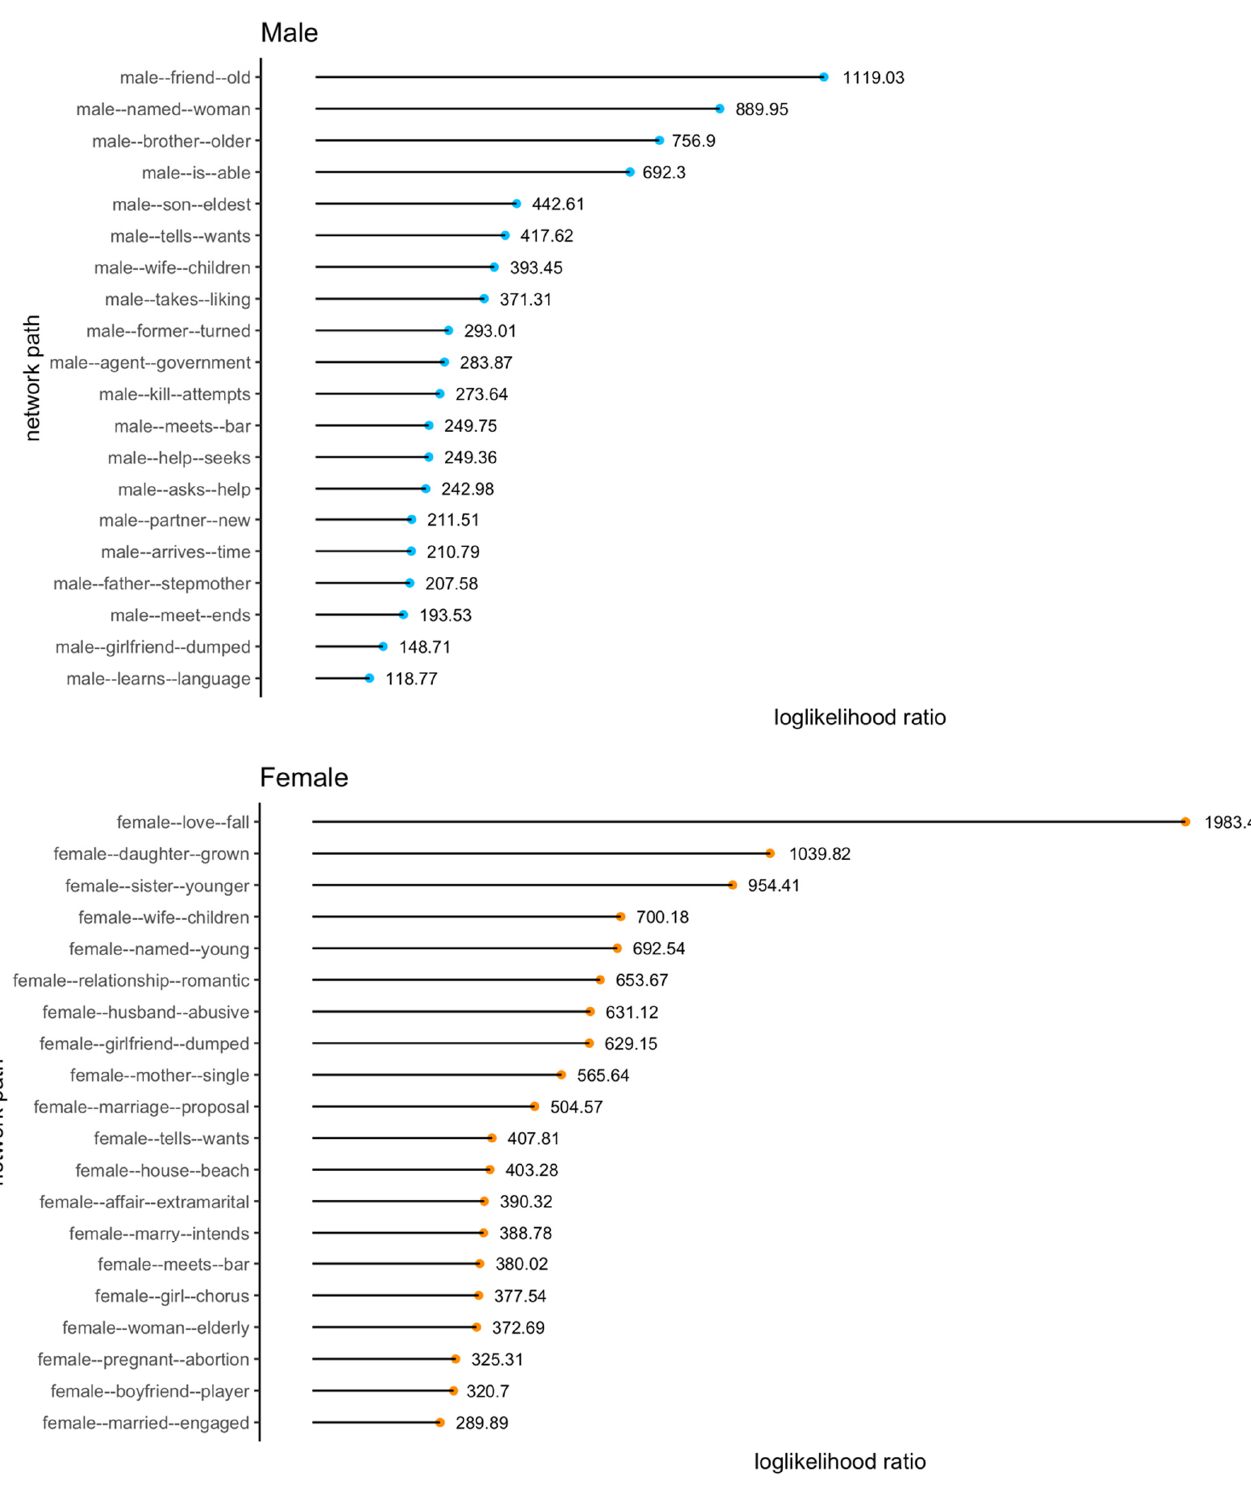
Figure 5. Needle plot representing the edge weights of the twenty most significant paths associated with male characters ( top ) and female characters ( bottom ).